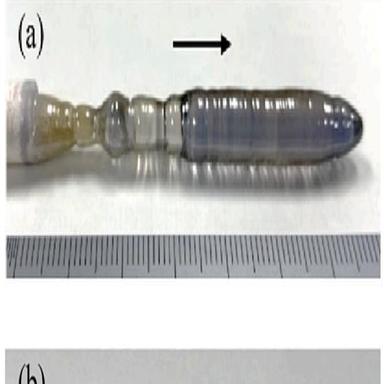
Photographs of the as-grown CaNb2O6 crystals in (a) Ar and (b) O2. The arrows indicate the growth direction.